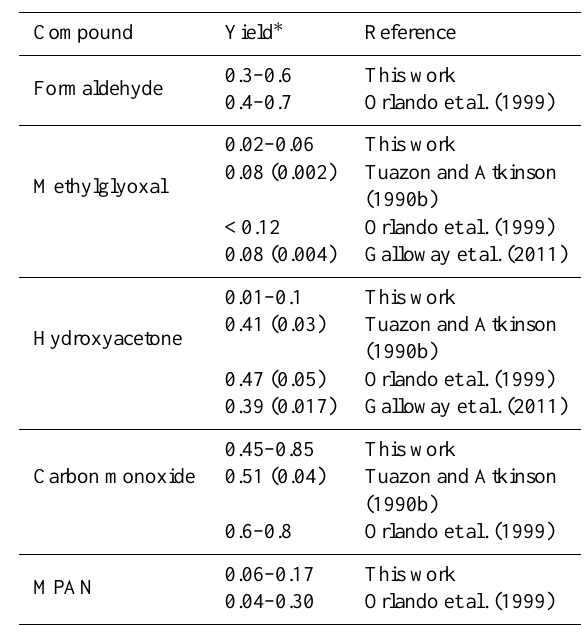
Table 4. Yields of first-generation oxidation products during methacrolein photooxidation compared with previous studies.